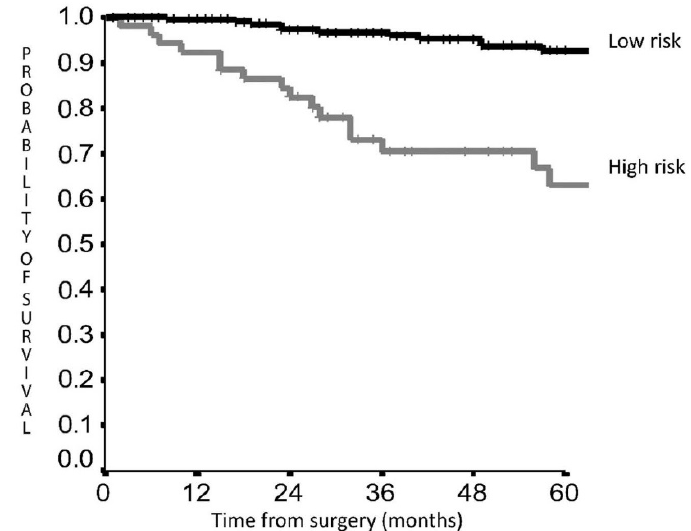
Figure 2. Disease-free survival according to score risk Figure 2. Disease ‐ free survival according to score risk classes.